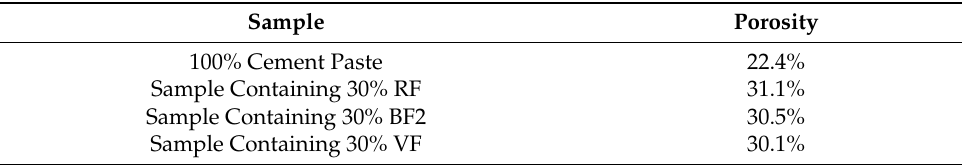
Figure 10. Pore structure of samples containing ground fly ash in different mill. ( a ) Cumulative porosity. ( b ) Incremental intrusion. Table 5. Porosity of different cement